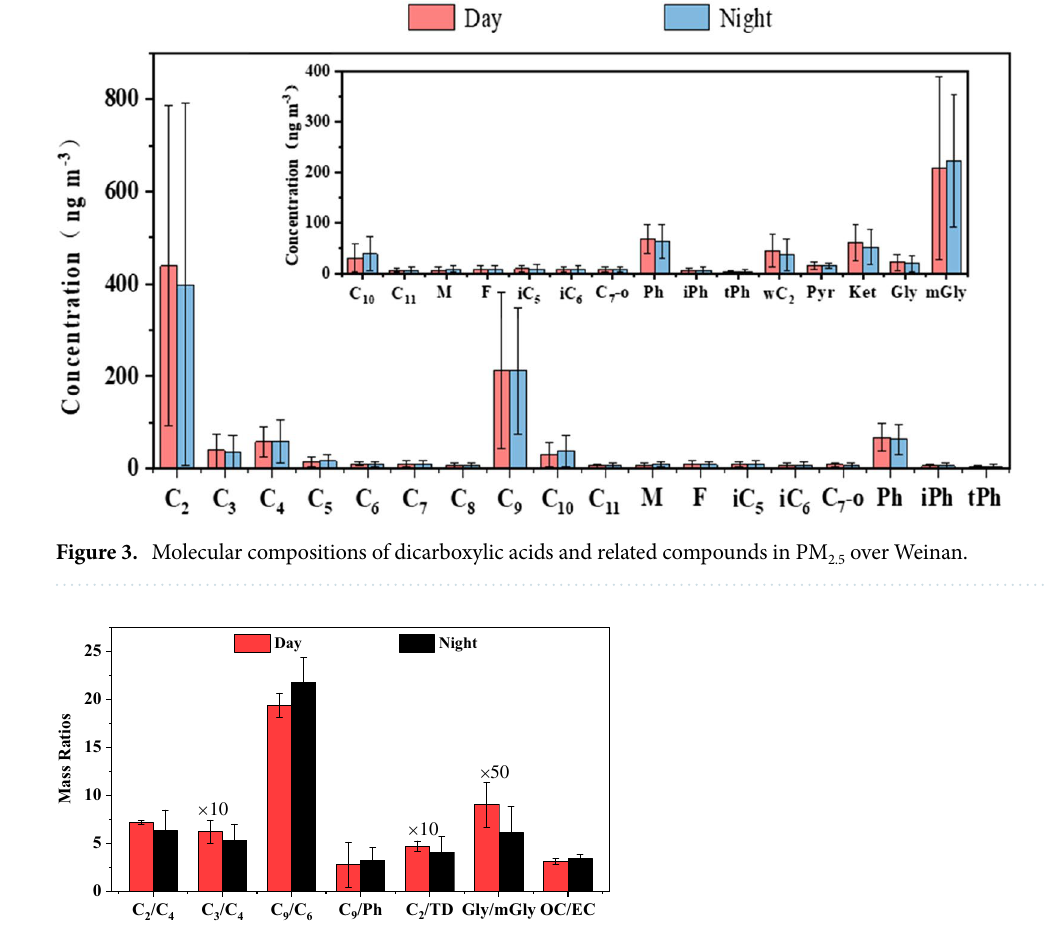
Figure 4. Diurnal variations of mass ratios of C 2 /C 4 , C 3 /C 4 , C 9 /C 6 , C 9 /Ph, C 2 /TD, Gly/mGly, and OC/EC (TD: total dicarboxylic acids; the mass ratios of C 2 /TD, C 3 /C 4 , and Gly/mGly expanding 10 and 50 times,